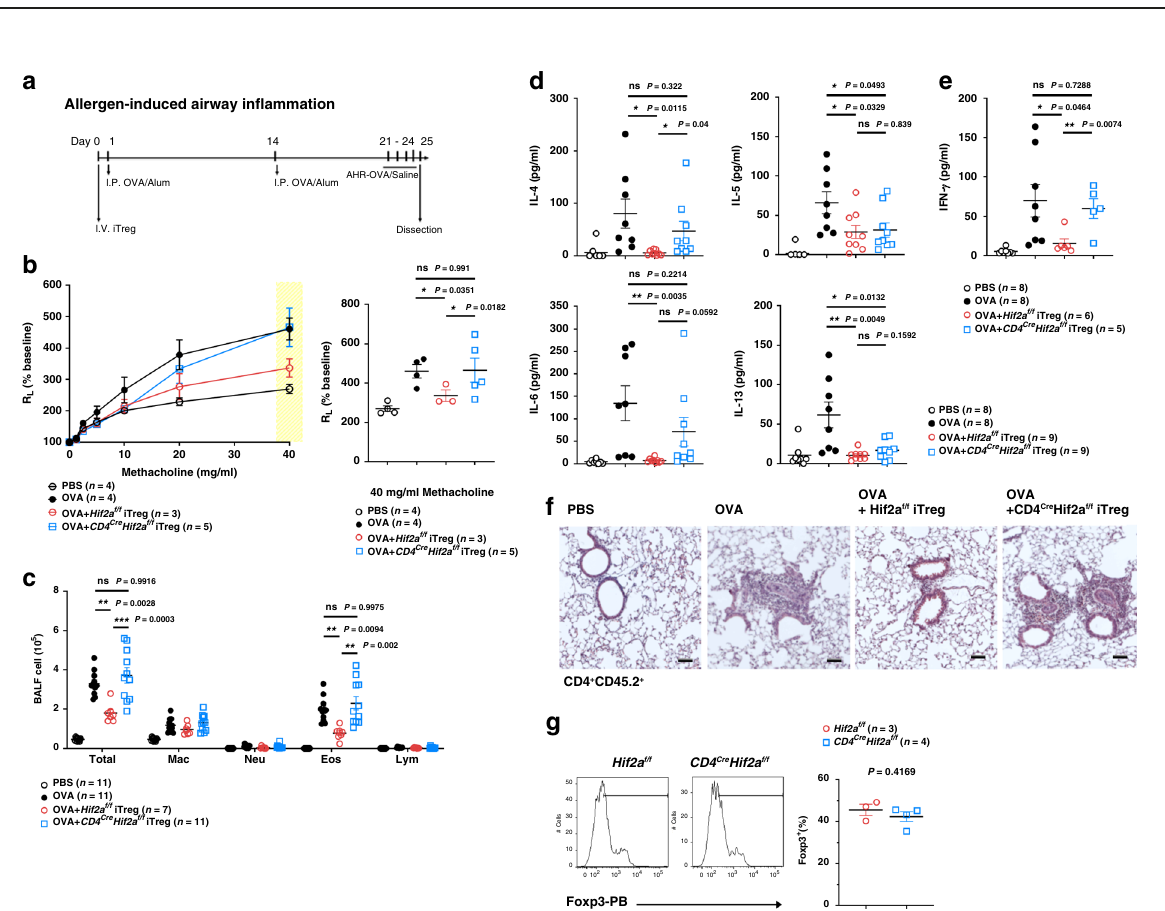
Fig. 3 HIF-2 α -KO increases conversion of Treg cells into IL-17A-secreting cells. a – c Increased transition of HIF-2 α -KO tTreg cells into IL-17-expressing cells. Hif2a f/f (WT) and Cd4 Cre Hif2a f/f tTreg cells were activated with plate-bound anti-CD3/CD28 (4/2 μ g ml − 1 ) and IL-2 (Th0), with an additional 50 ng/ ml of IL-12 (Th1), or an additional IL-6 (50 ng ml − 1 ) plus IL-1 (IL-1 α and IL-1 β , 20 ng ml − 1 each) (Th17) for 5 days. IFN- γ a and IL-17A b levels were measured in supernatants collected from tTreg cells reactivated by TPA/A23187 (20/200 ng ml − 1 ) for 16 h. Data a , b are expressed as mean ± SD, n = 3. The frequency of Foxp3 + cells was determined by intracellular staining, and representative plots of four independent experiments are shown in the left panel of c . Right panel c , data are expressed as mean ± SEM, n = 4. Red circle, Hif2a f/f ; blue square, Cd4 Cre Hif2a f/f . ** P = 0.0057 (Th0), 0.0024 (Th1); *** P < 0.001 (Th17) ( b ). d , e Increased conversion of HIF-2 α - KO iTreg cells into IL-17-producing cells. Hif2a f/f (WT) and Cd4 Cre Hif2a f/f iTreg cells, generated as described in Fig. 1c, were rested for 2 days and then reactivated with plate-bound anti-CD3/CD28 (4/2 μ g ml − 1 ) under Th1-, Th2-, and Th17- priming conditions as described in a . Re-programmed iTreg cells were activated by TPA/A23187, and IFN- γ ( d ) and IL-17A ( e ) production was quantitated. Data are expressed as mean ± SEM, n = 6. * P = 0.011 ( e ). f Normal HIF-2 α -de fi cient T helper cell differentiation. Naïve T cells (CD4 + CD25 − CD44 lo CD62L hi ) from Hif2a f/f and Cd4 Cre Hif2a f/f mice were differentiated under either Th1-, Th2-, or Th17-polarizing conditions, as described in Methods, for 5 days. T cells were then re-stimulated with TPA/A23187 (50/500 ng ml − 1 ), and expression of IFN- γ , IL-4, and IL-17 was determined by intracellular staining. Numbers represent the percentage of cells positive for IFN- γ , IL-4, or IL-17. Left, representative plots of three independent experiments are shown. Right, data are expressed as mean ± SEM. n = 3 (IFN- γ + ) or n = 4 (IL-4 + or IL-17 + ) . *** P < 0.001. P- value was determined by two-tailed unpaired t -test ( a – f ). Source data are provided as a Source data fi le.